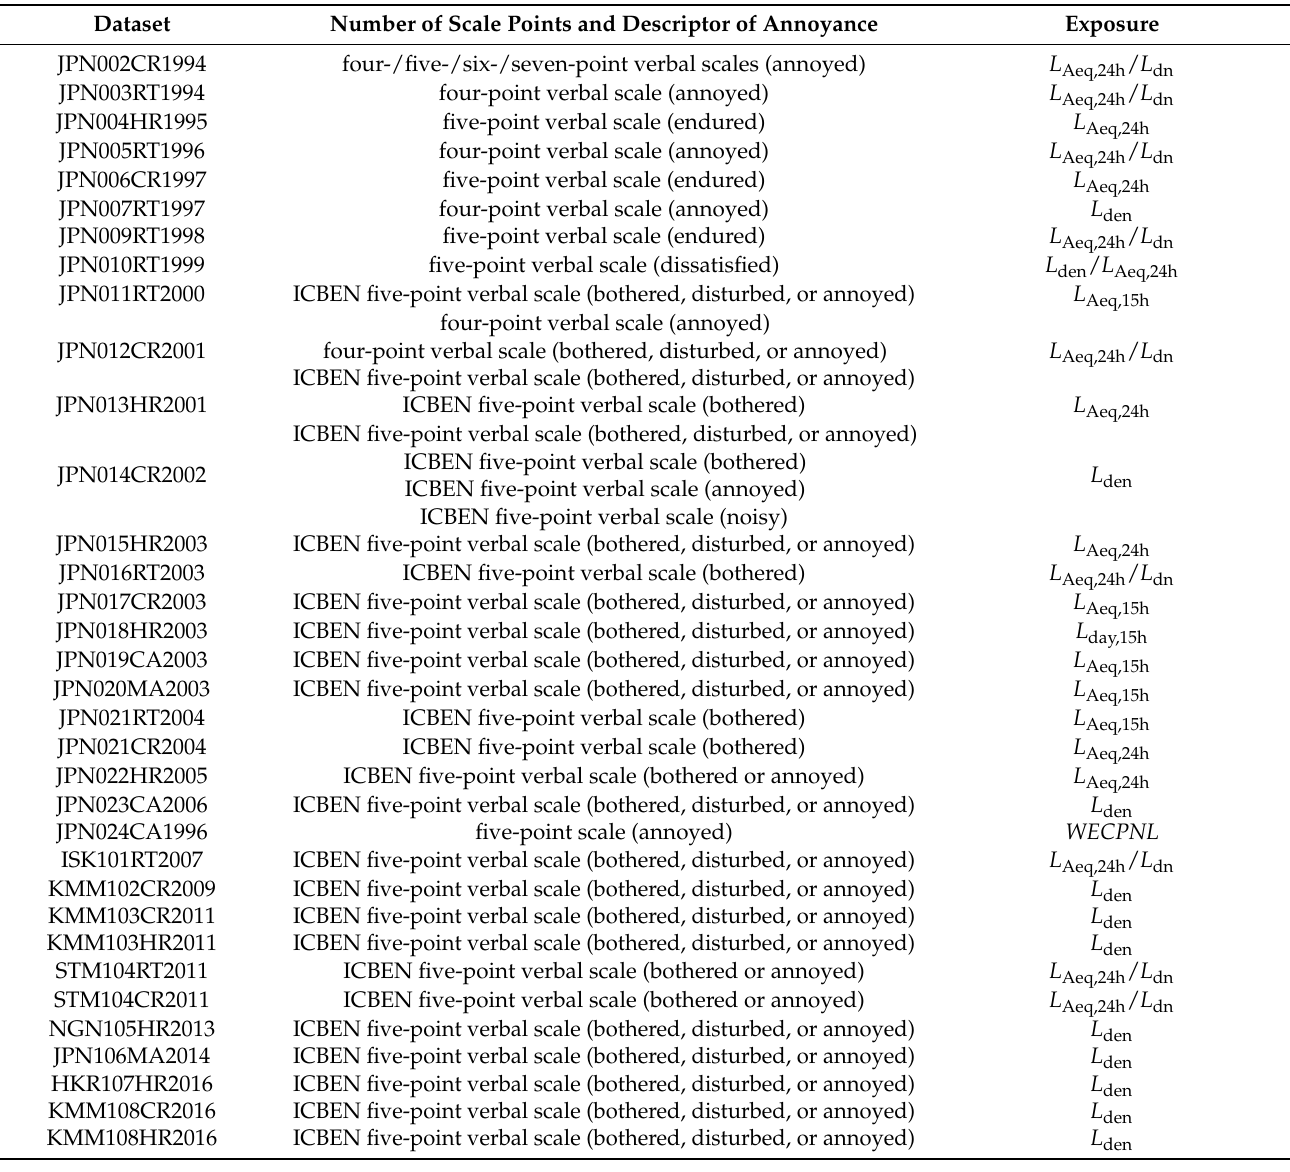
Table 2. List of the number of scale points and descriptor of annoyance due to specific noise source and noise exposure.